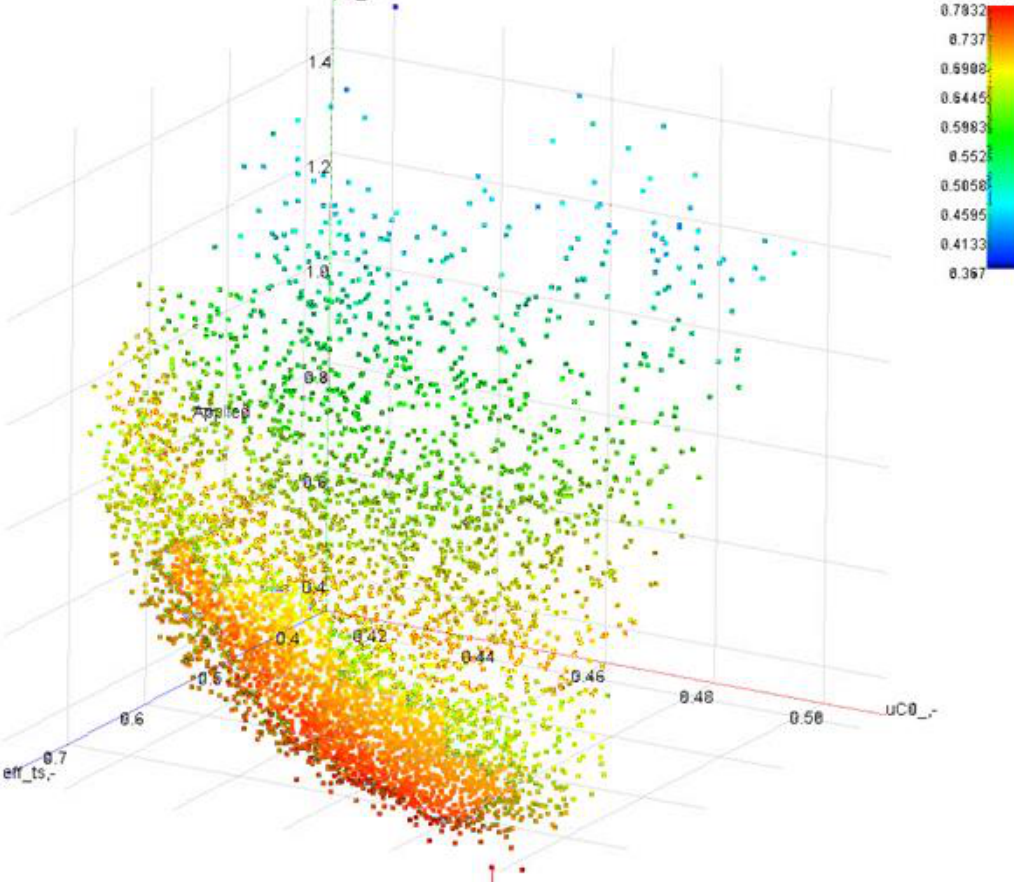
Figure 6. Plot of all the generated preliminary turbine design performance parameters (total to static efficiency (eff_ts), blade speed ratio (U/C0) and flow coefficient (phi)).